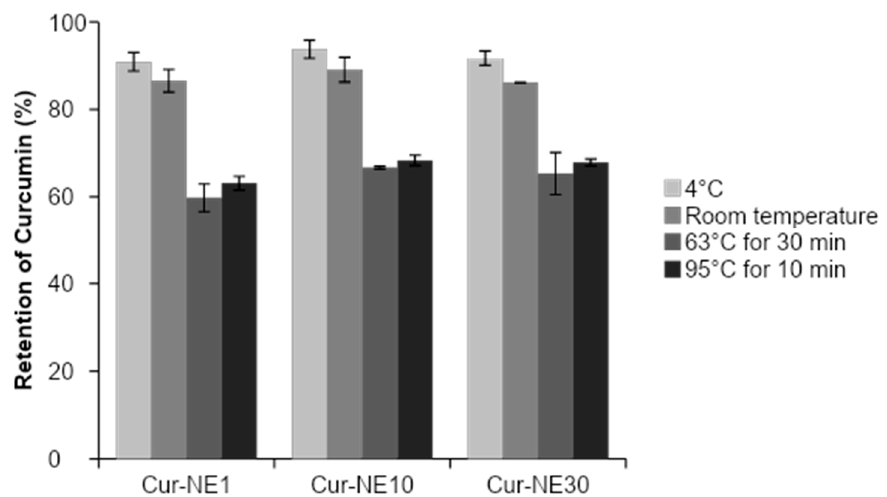
Figure 3. Retention rate of entrapped curcumin loaded in nanoemulsions (NE) systems exposed to refrigerator (4 °C) and room temperature for 15 days, and then during thermal treatments at 63 °C for 30 min and 95 °C for 10 min, respectively.